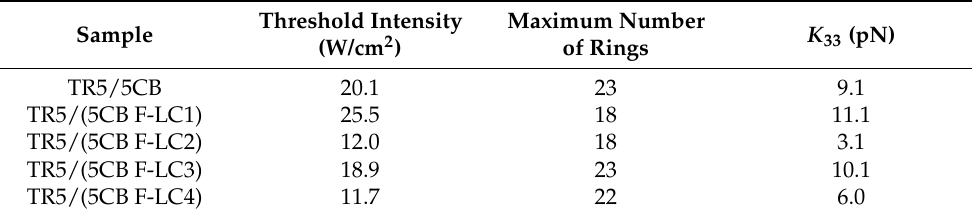
Table 2. Threshold intensity, the maximum number of rings, and K 33 elastic constant for